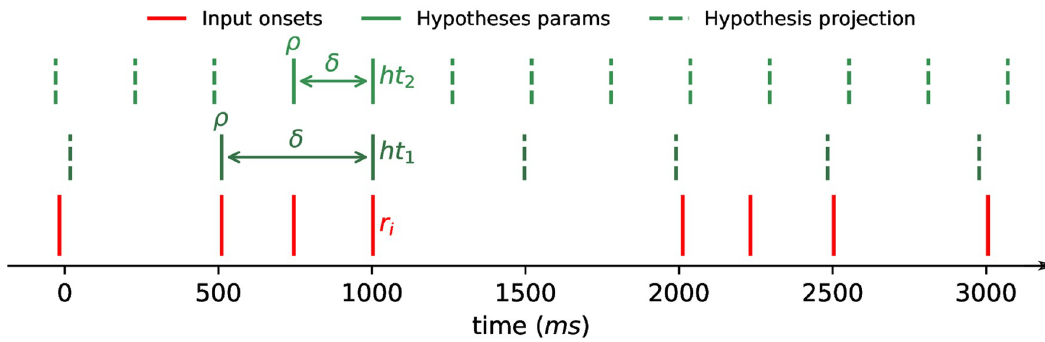
Fig 1. Depiction of an input ( r i ) and two tactus hypotheses ( ht 1 and ht 2 ), their parameters and